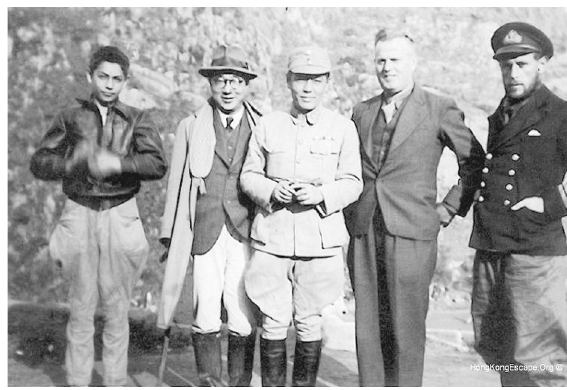
Figure 2. Robert Kho-Seng Lim and others in Kweiyang (in the middle is Dr.